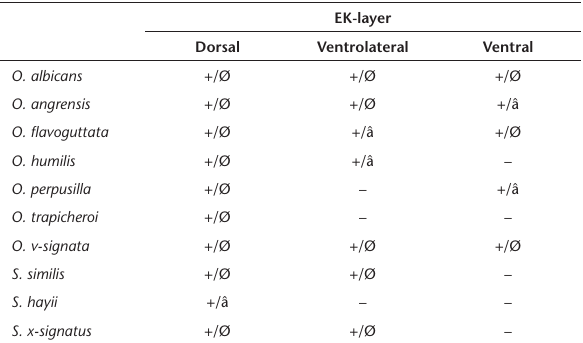
Table 6. Occurrence of the EK-layer in the integument of Oloygon spp. and Scinax spp. The EK-layer can occur as a continuous or discontinuous layer.